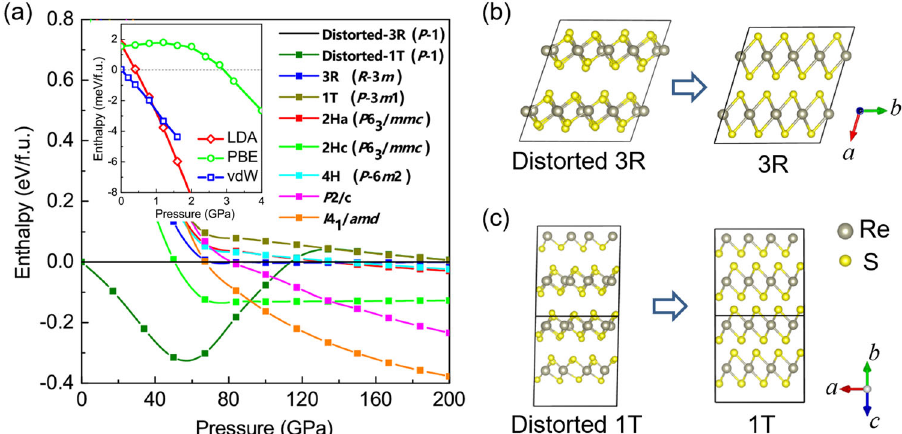
Fig. 1 Energetic stability and crystal structures. a Enthalpy curves (relative to the ambient pressure distorted-3R phase) of the interested structures as a function of pressure. The inset shows the calculated enthalpy curves of newly found distorted-1T (relative to the distorted-3R) using different exchange-correlation functionals. Pressure-induced symmetrization of the distorted-3R ( b ) and distorted-1T structures ( c